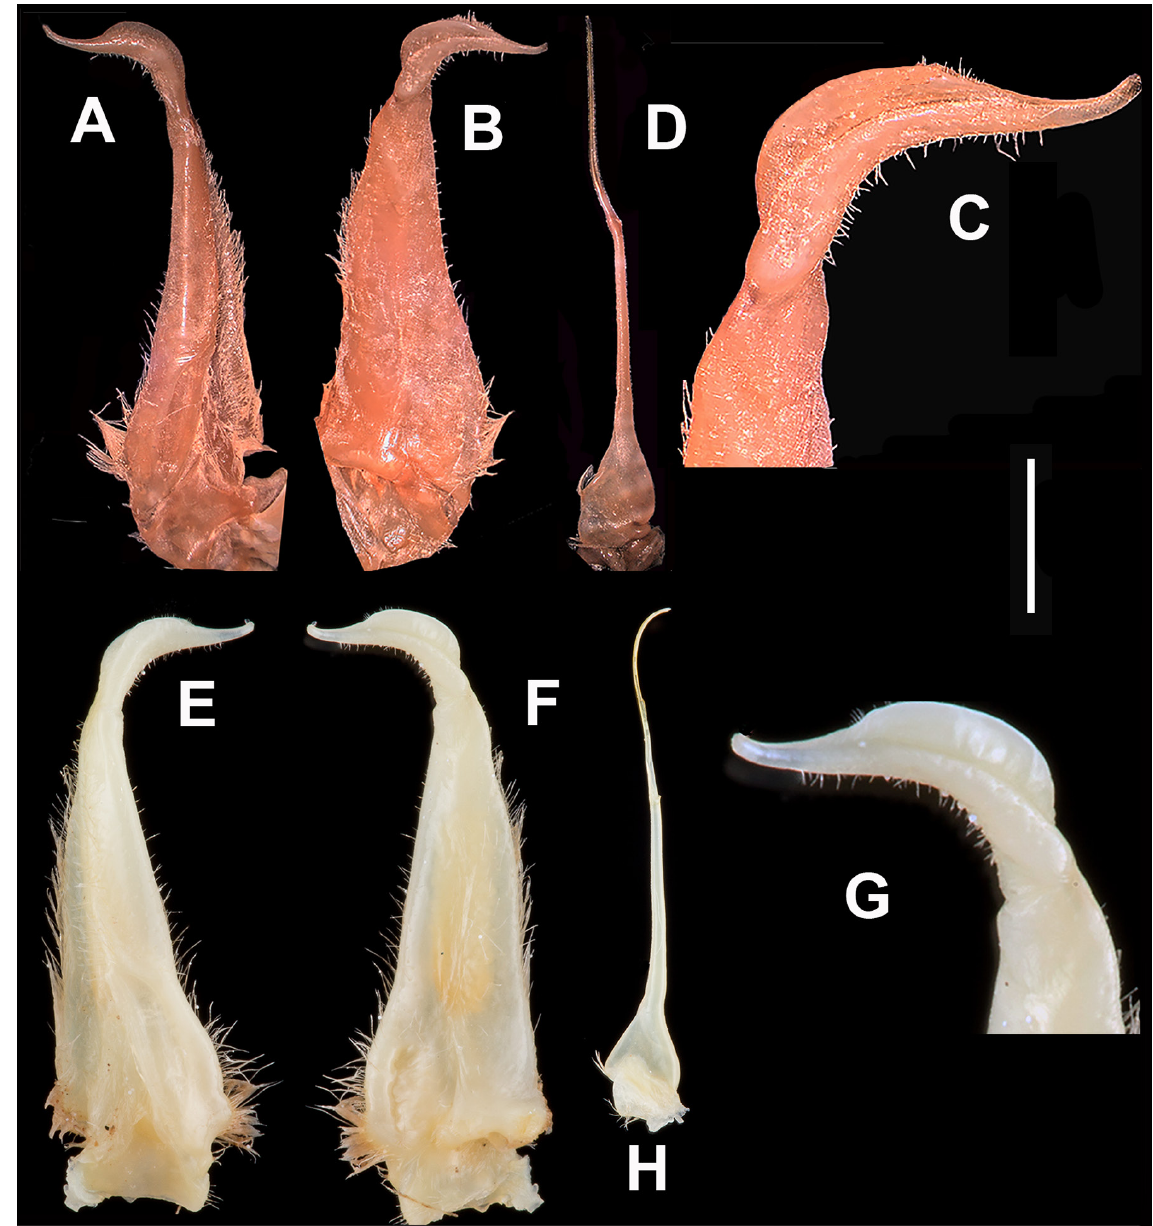
Fig. 12. Potamonautes orbitospinus (Cunnington, 1907). A–D . Lectotype, adult, ♂, CW 56.9 mm, from Nkhata Bay, Lake Malawi, Malawi (NHMUK 1908.1.31.27). A . G1, ventral view. B – C . G1, dorsal view. D . G2, ventral view. E–H . Adult, ♂, Cape Maclear, Lake Malawi, Malawi (AMG CAW 467A). E . G1, ventral view. F – G . G1, dorsal view. H . G2, ventral view. Scale bar: A–B, E–F = 3 mm; C, G = 1.3 mm; D, H = 1.2